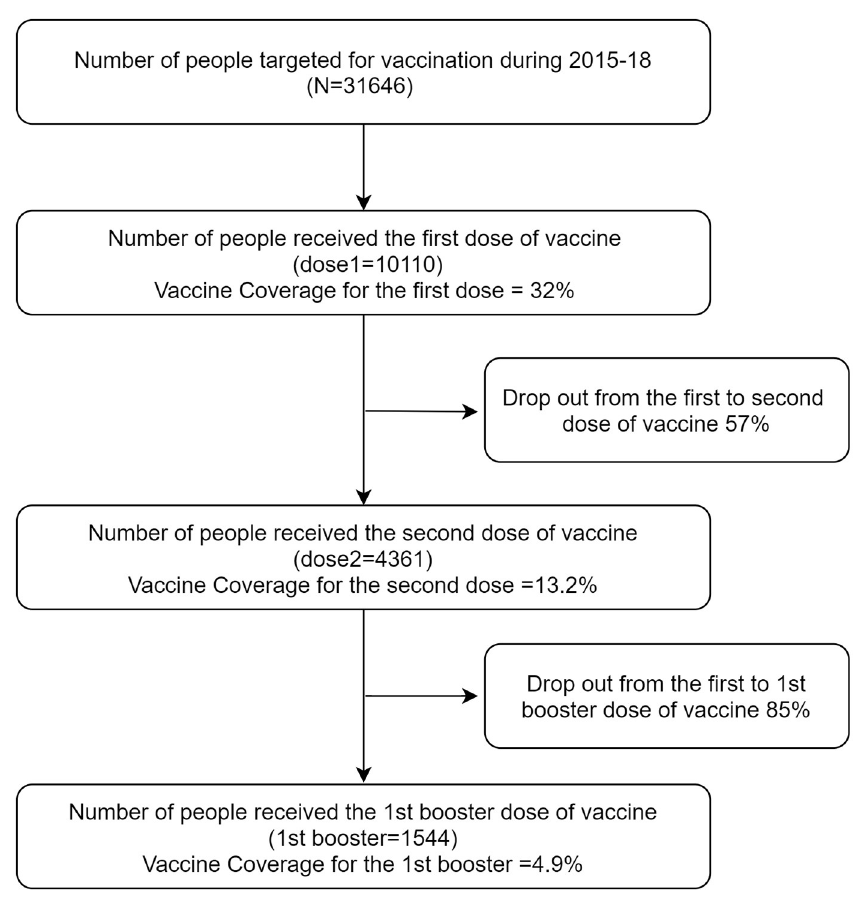
Fig 1. Flow diagram depicting vaccination coverage for KFD and vaccine dropout rates in affected villages of Goa, 2015–18.